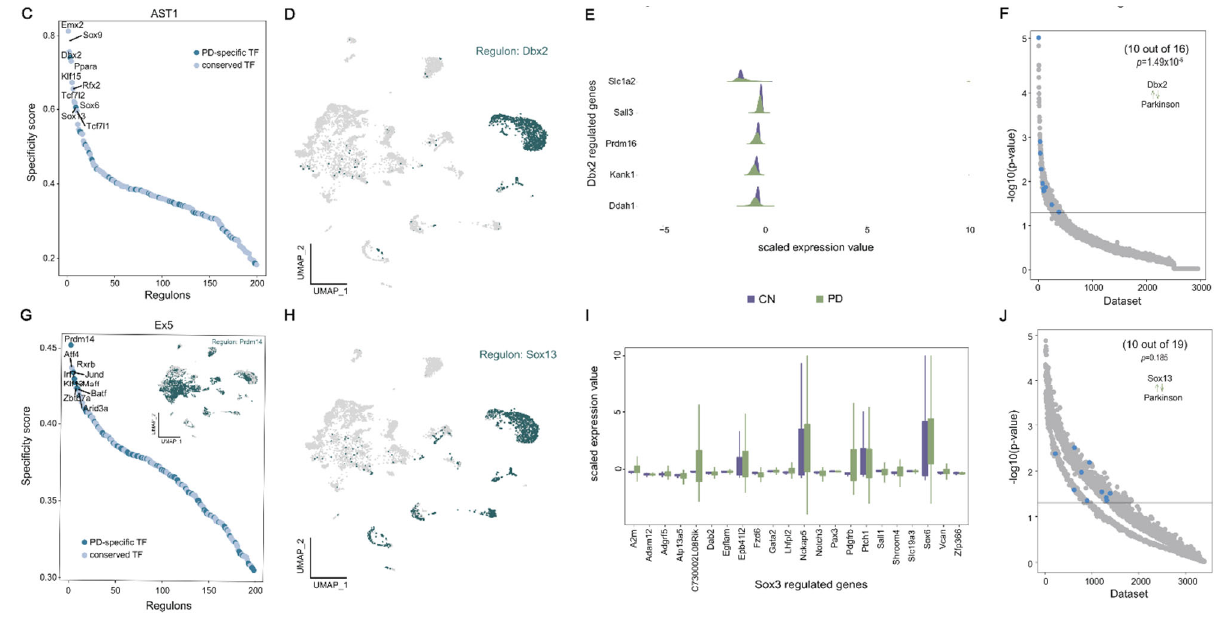
Figure 2. Cell type-specific transcription factors in disease. ( A ) Venn plots of conservative and specific TFs in PD and CN. Middle Venn plot shows conservative and specific TFs detected in PD and CN. The circle percentage diagram with word cloud insert detailed presents that specific TFs of CN and PD were mainly derived from Ex5 and AST1; the colors of circle diagram and word cloud plot correspond. ( B ) Heatmap of top three specific TFs for each cell type in PD ( left ) and CN ( right ). ( C , G ) The rank of regulons in AST1 and Ex5 based on regulon specificity score. ( D , H ) Binarized regulon activity scores for top regulons Dbx2 and Sox13 on UMAP map (dark green dots). ( E , I ) Expression levels of Dbx2 and Sox3 transcription-regulated target genes in AST1. ( F , J ) SEEK co-expression result for target genes of top regulons Dbx2 and Sox13 in different public datasets. The x-axis represents different datasets, and the y ‐ axis represents the co ‐ expression significance of target genes in each dataset; AST1 ‐ related datasets with significant correlation ( p ‐ value < 0.01) are highlighted by blue dots.